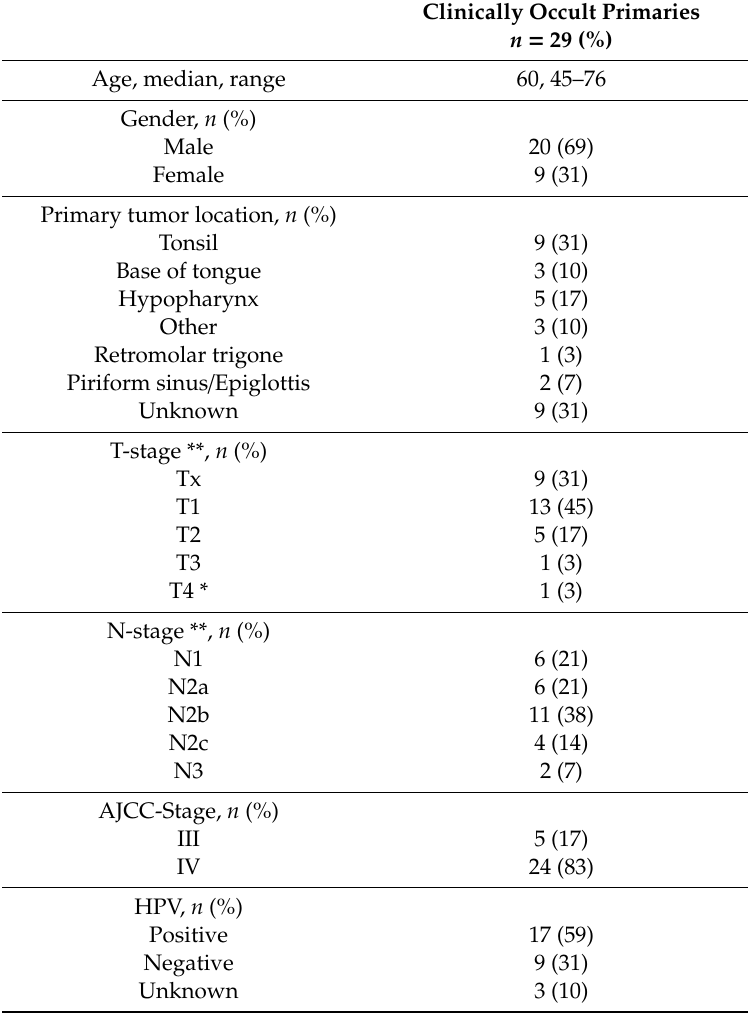
Table 1. Baseline